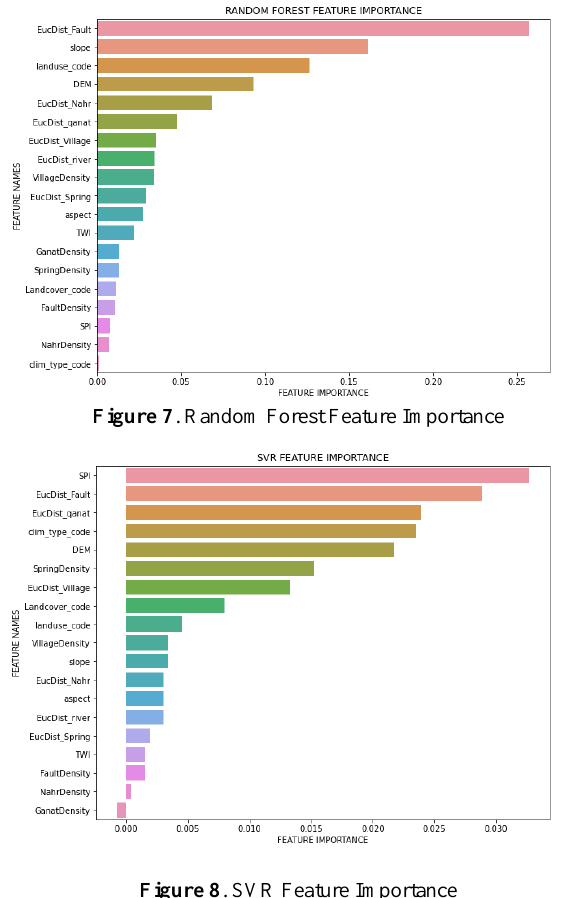
Figure 8 . SVR Feature Importance